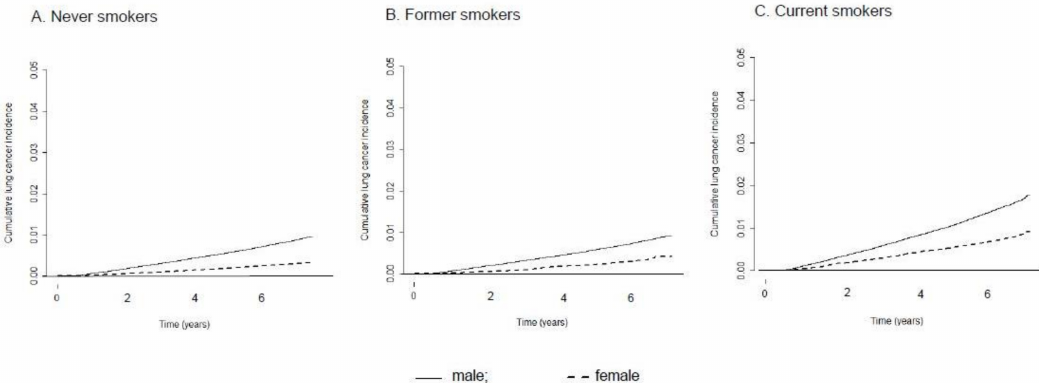
Figure 1. Cumulative lung cancer incidence in men and women according to smoking status. ( A ) Never smokers, ( B ) Former smokers and ( C ) Current smokers.